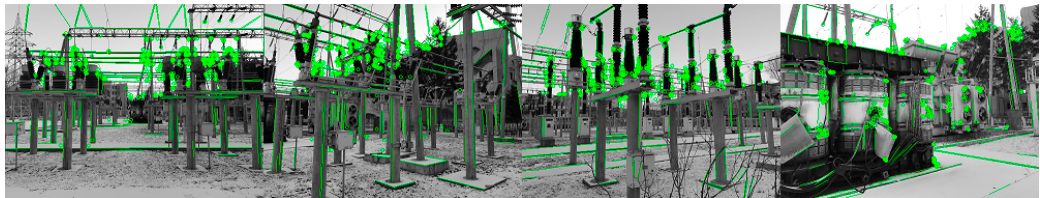
Figure 13. Feature extractions of the VIO front-end in the substation scene.